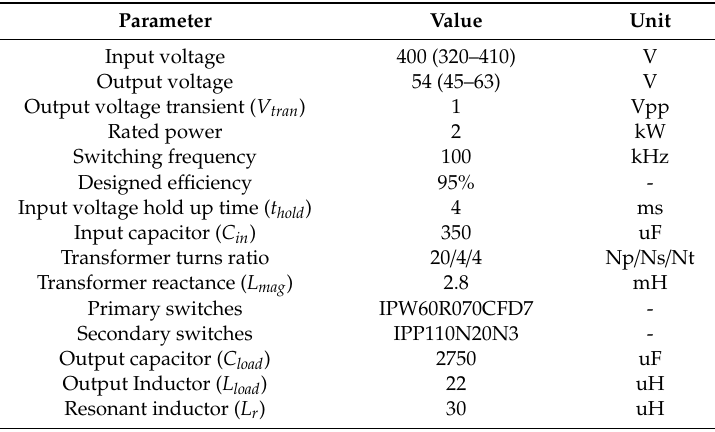
Table 2. DC–DC Converter Specifications and Design